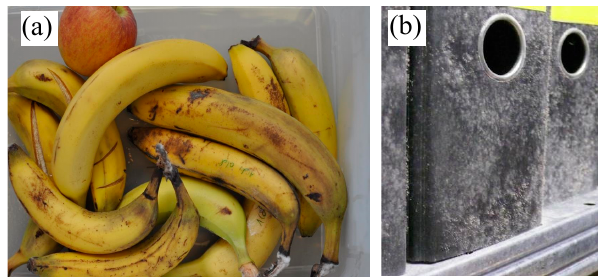
Figure 1. Photos showing mold contamination on bananas ( a ) and on files ( b ). Source: BMA Labor GmbH.